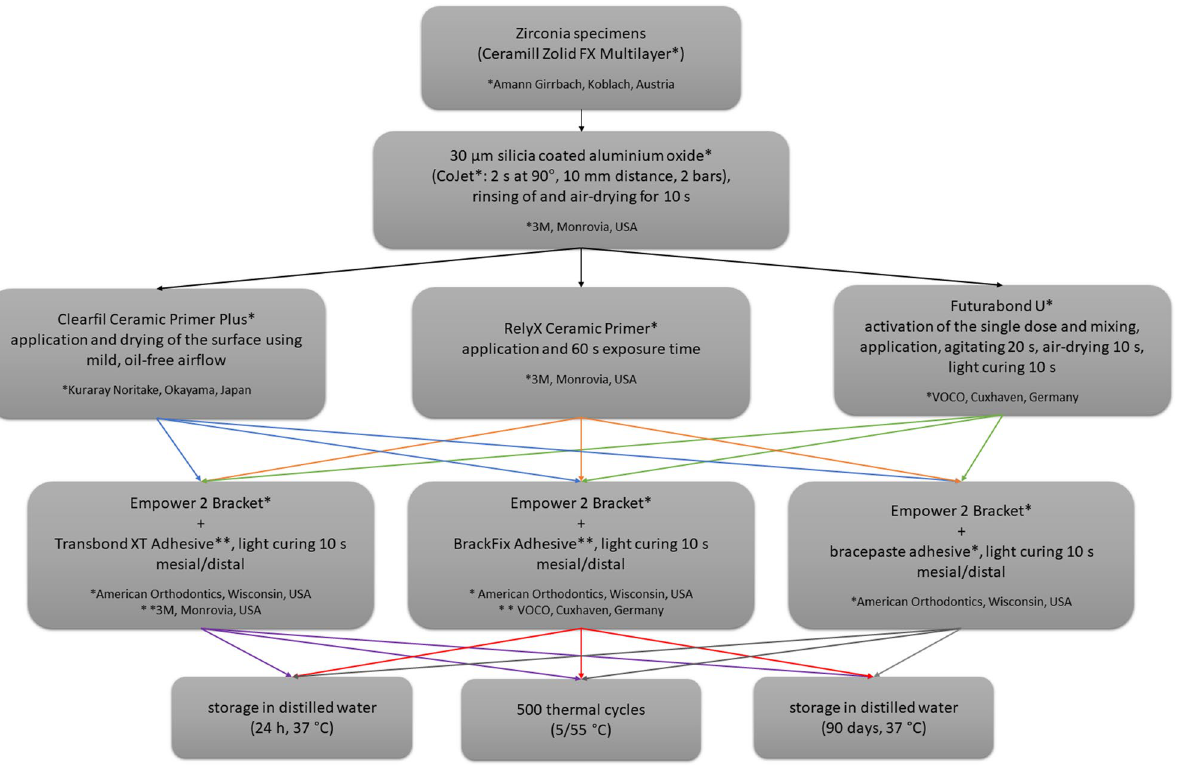
Figure 1. Study workflow. The flowchart shows different pretreatments, attachment materials, and aging regimens of zirconia